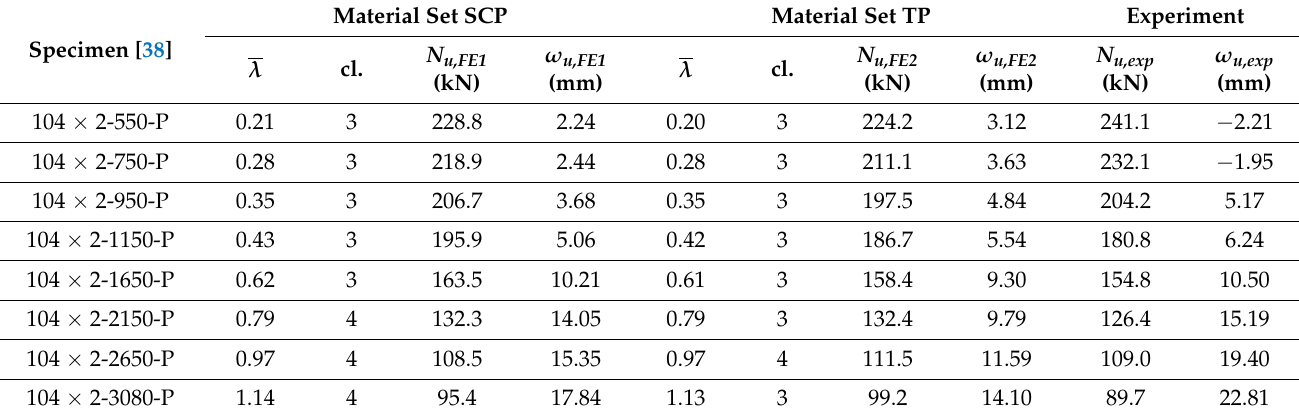
Table 9. Approach #A, FEA, and experiment results of the cross-section set 104 × 2 CHS pin-ended columns. Material Set SCP Material Set TP Specimen [38]